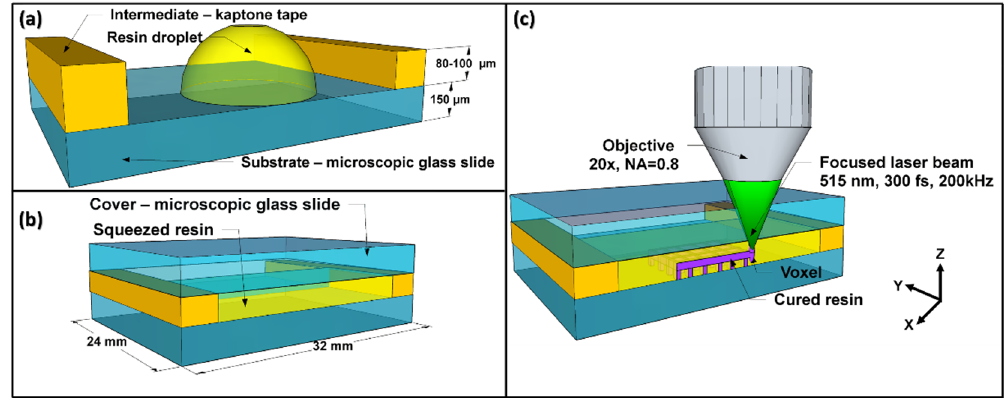
Figure 1. The explanatory scheme of a sample preparation and Direct Laser Writing (DLW) 3D lithography: ( a ) Kapton tape attached to the glass slide and working as an intermediate, resin’s droplet drop cast on such a substrate; ( b ) another glass slide used as a cover to squeeze the droplet and spread it uniformly through the substrate; ( c ) laser beam focused through the cover glass into the resin and initiating the 3D confined polymerization reaction.